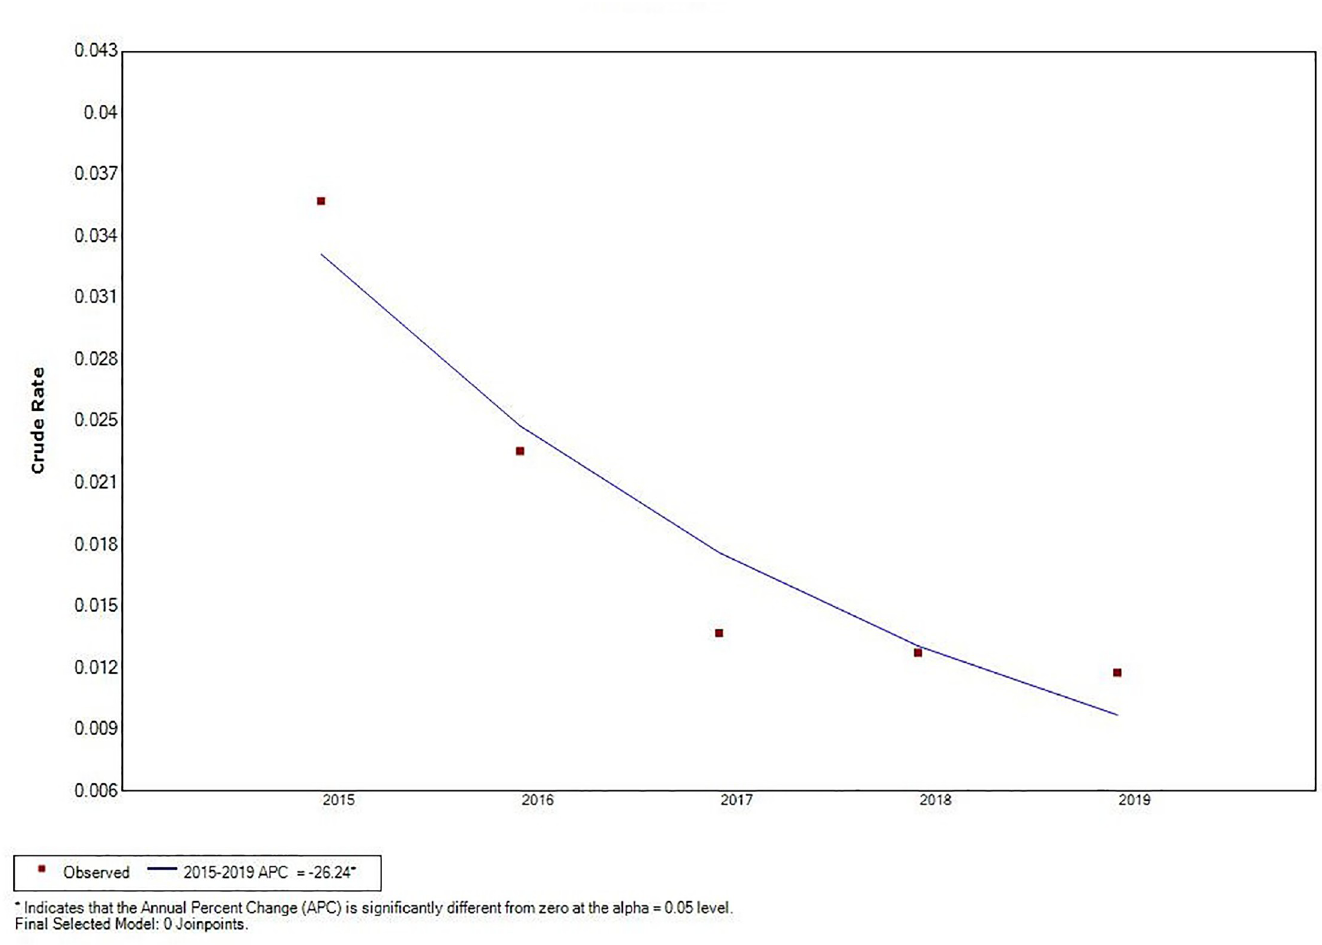
Fig 3. The joinpoint regression analysis for determining changes in the trend of visceral leishmaniasis incidence in China from 2015 to 2019.